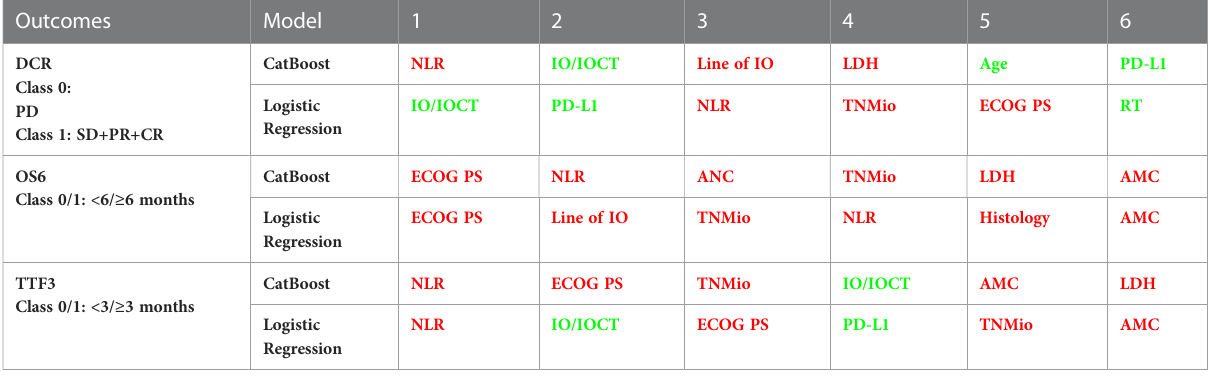
TABLE 6 List of the most important features for DCR, OS6 and TTF3.